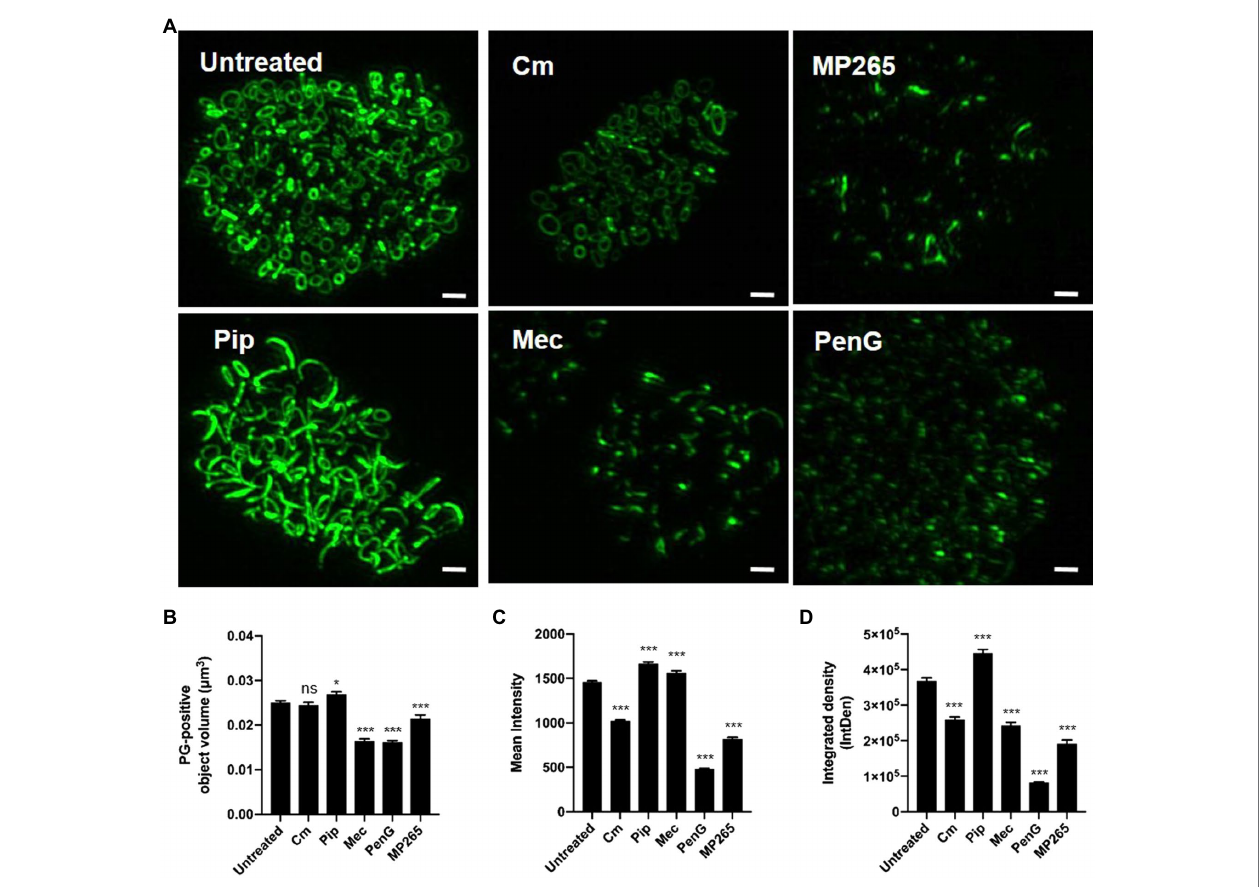
FIGURE 4 | PG ring volume and labeling intensity are directly influenced by protein synthesis, MreB polymerization, and penicillin-binding protein activity. (A) PG- labeled objects present within C. trachomatis inclusions 24 h post-infection that have either been left untreated, or have been treated for 2 h with the chemical inhibitors specified. Scale bars ~2 μ m. Average object volume (B) , mean fluorescent intensity (C) , and integrated density (D) for each group were then compared to untreated controls. A statistical analysis was conducted utilizing one-way ANOVA with multiple comparisons testing. Values represent data acquired from 10 inclusions per experimental group collected over two independent biological replicates. Cm; Chloramphenicol, MP265; MreB polymerization inhibitor, Pip; Piperacillin, Mec; Mecillinam, PenG; Penicillin G. * p < 0.05, *** p < 0.001, ns; not